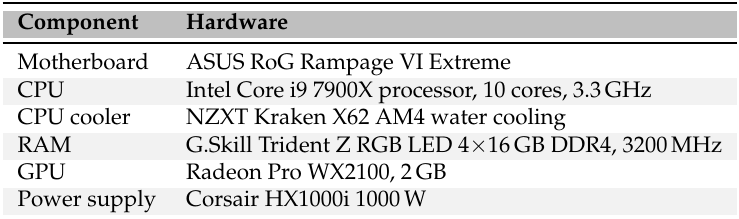
Table 2. Specifications of simulation